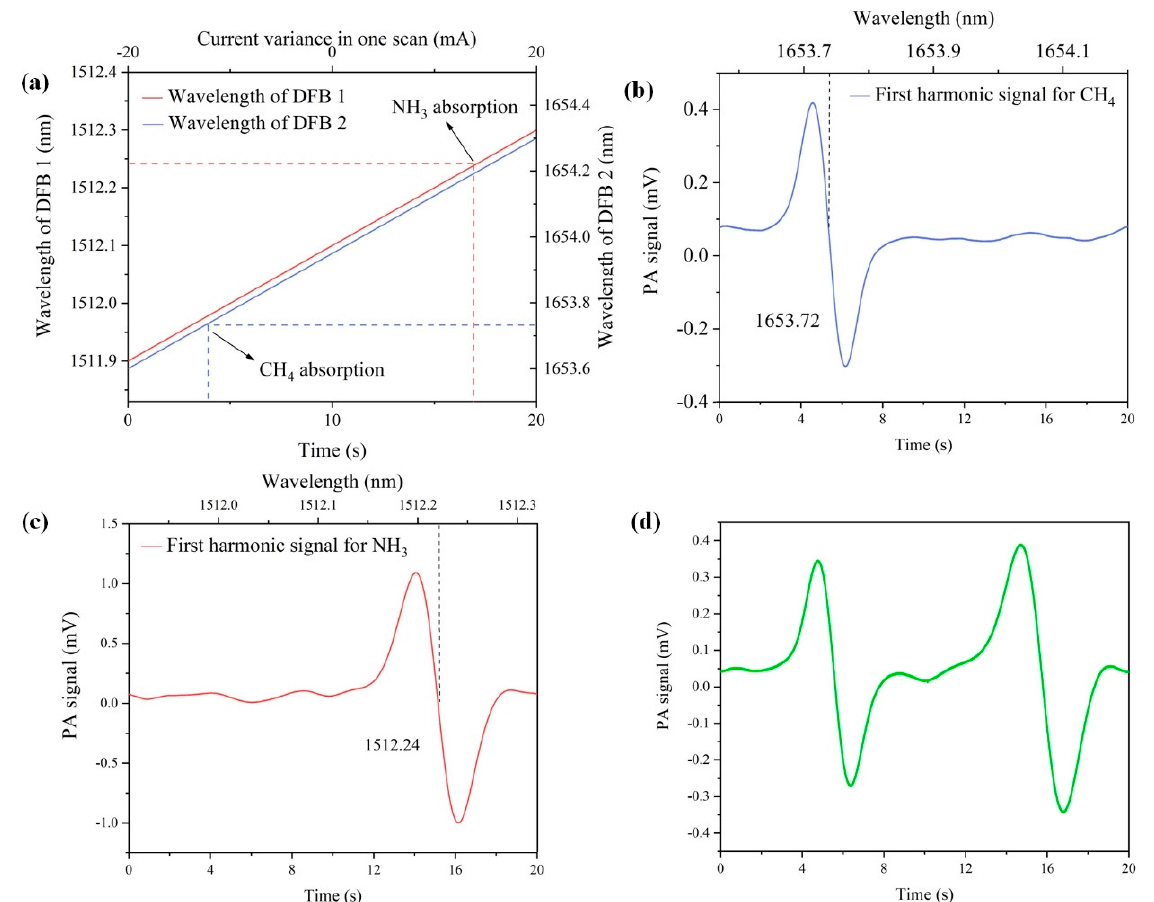
Figure 2. ( a ) Plot of the relationships of time and wavelength of lasers during one frequency scan. ( b ) First harmonic signal of 100 ppm NH 3 during one frequency scan. ( c ) First harmonic signal of 80 ppm CH 4 during one frequency scan. ( d ) Simultaneous recording of the PAS of 60 ppm CH 4 and 50 ppm NH 3 . All measurements were taken at room temperature (around 300 K) and one standard atmosphere (atm).